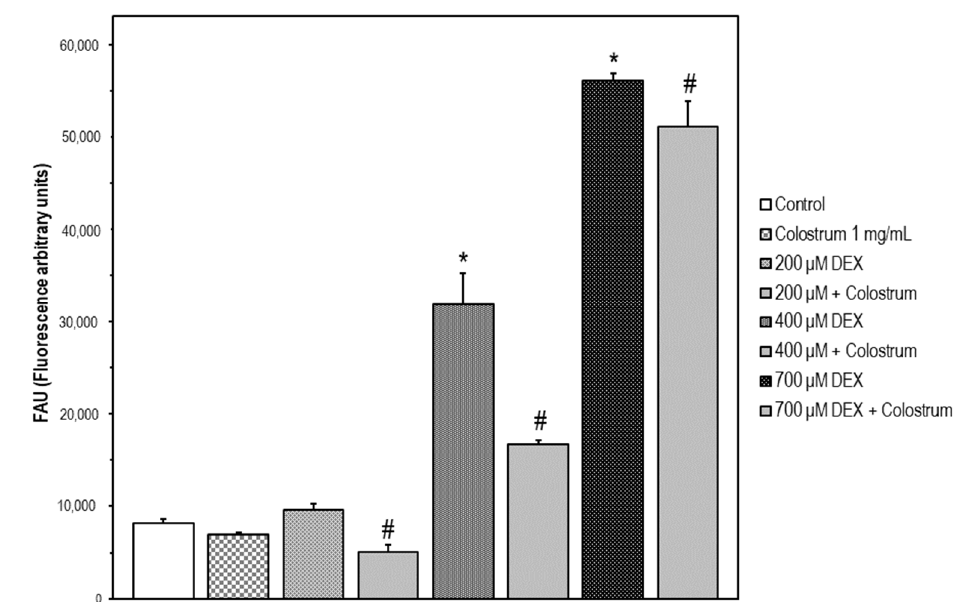
Figure 4. DEX-induced caspase-3 activation in SH-5Y5Y is attenuated by colostrum treatment. Caspase-3 activity was determined using the fluorogenic substrate Ac-DEVD-AMC. Data are ex- pressed in fluorescence arbitrary units (FAU) and represent the mean ± S.E.M. of three independent experiments. Significant differences of 400 μ M and 700 μ M DEX treated cells versus the control untreated cells were found (Newman–Keuls test, * p < 0.001 vs. control). Significant differences of colostrum plus DEX treated cells versus DEX-treated cells were found (Newman–Keuls test, # p < 0.05 vs. DEX treated cells).